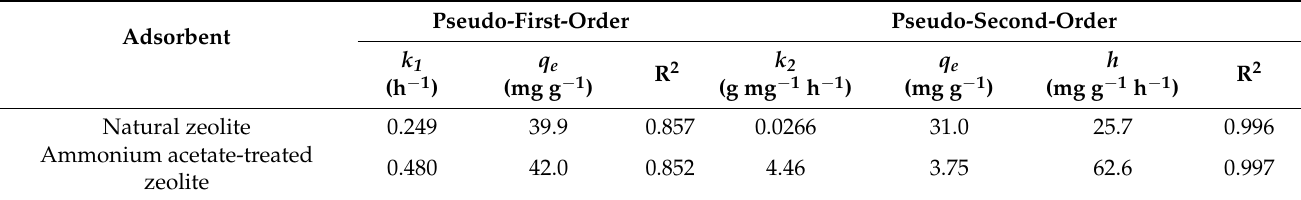
Table 2. Parameters of kinetic models for K adsorption by natural zeolite and ammonium acetate-treated zeolite.